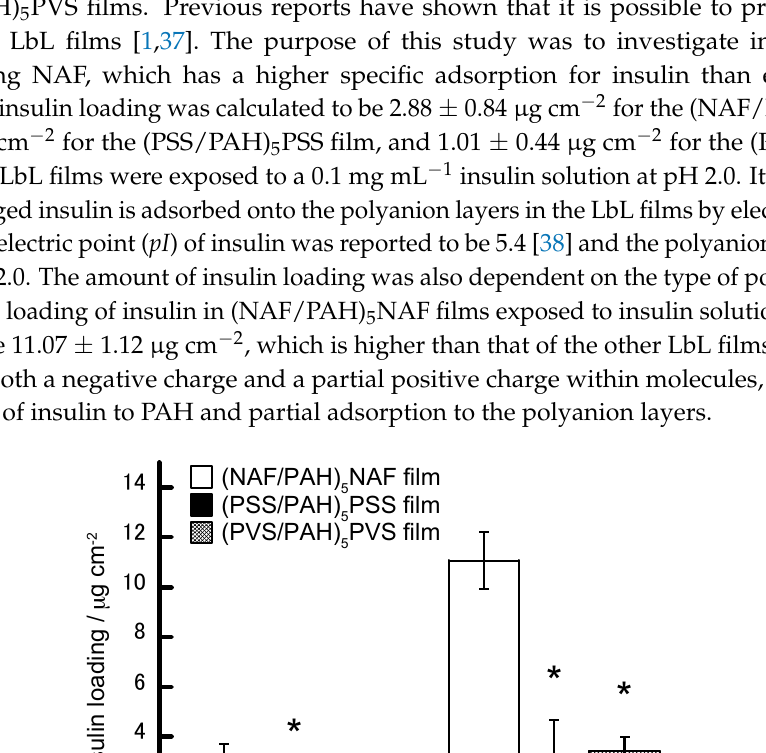
Figure 4. UV-visible absorption spectra for the (NAF/PAH) 5 NAF film ( a ) before and ( b ) after exposure to a 1 mg mL − 1 insulin solution (pH 7.4) for 12 h.